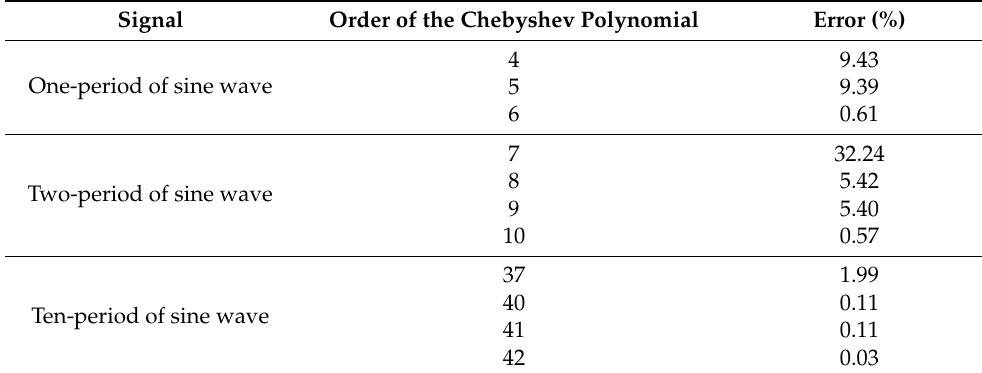
Table 1. Error of the Re-construction with different order Chebyshev polynomial. Signal Order of the Chebyshev